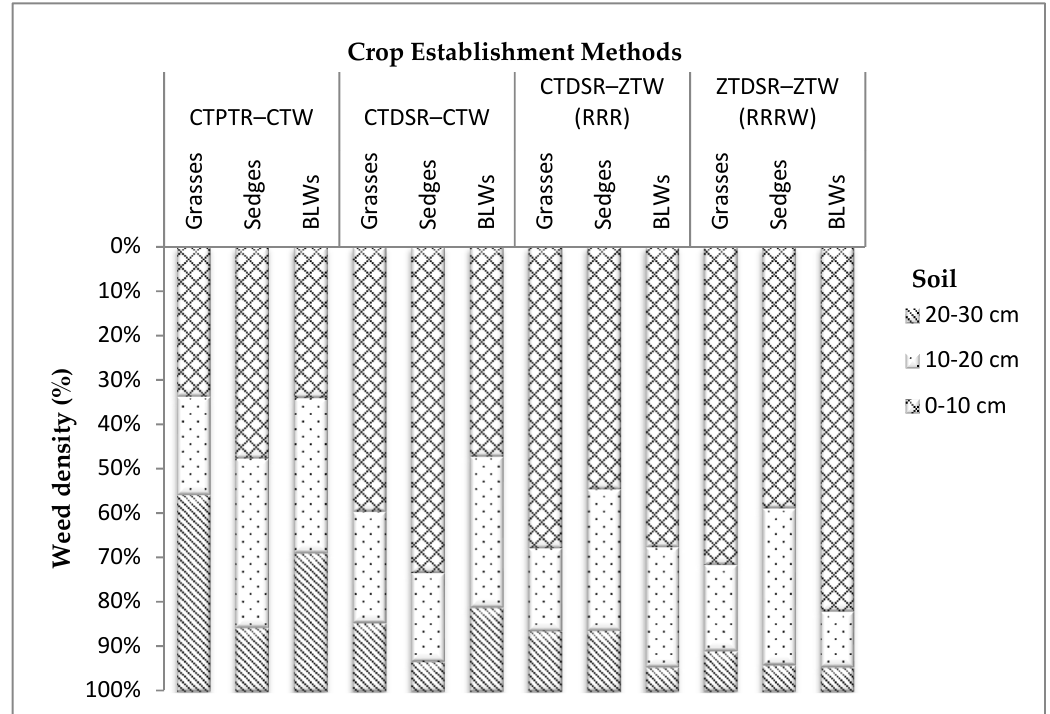
Figure 1. Vertical distribution of grasses, sedges and broadleaved weeds (BLWs) in different crop establishment methods of rice-wheat cropping system of Indo-Gangetic Plains. CTPTR-CTW, Conventional Till (CT) Puddle Transplanted Rice—CT wheat; CTDSR-CTW, CT dry Direct Seeded Rice (DSR)—CT Wheat; CTDSR-ZTW (RRR), CT dry DSR—Zero-till (ZT) Wheat (residue retention in rice); ZTDSR-ZTW (RRRW), ZT DSR—ZT Wheat (residue retention in rice and wheat). Note: the